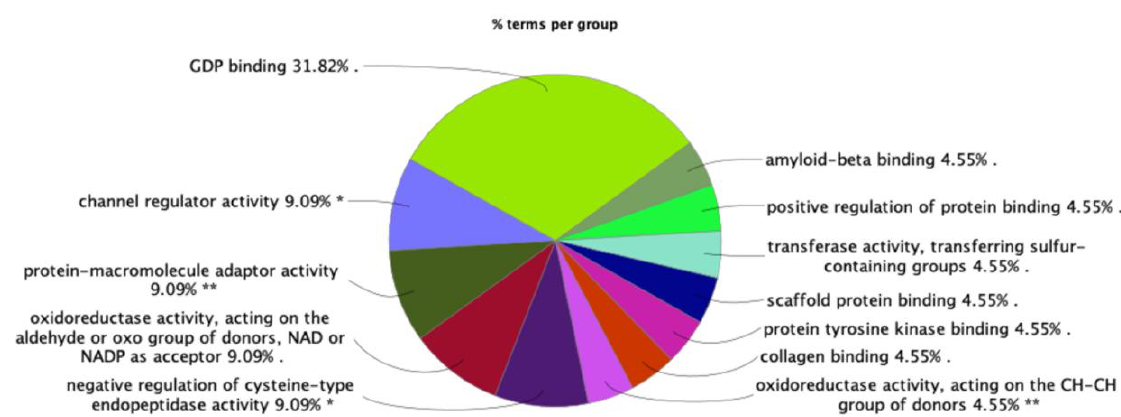
Figure 2. Distribution of functional categories of gene ontology (GO) terms associated with DEPs in the oxy-exposed neuroglial cultures. The size of each category within the pie chart represents the percentage of included terms. All enriched GO terms are statistically significant. Single (*) or double (**) asterisk indicate significant enriched GO terms at the p < 0.05 and p < 0.01 statistical levels, respectively.